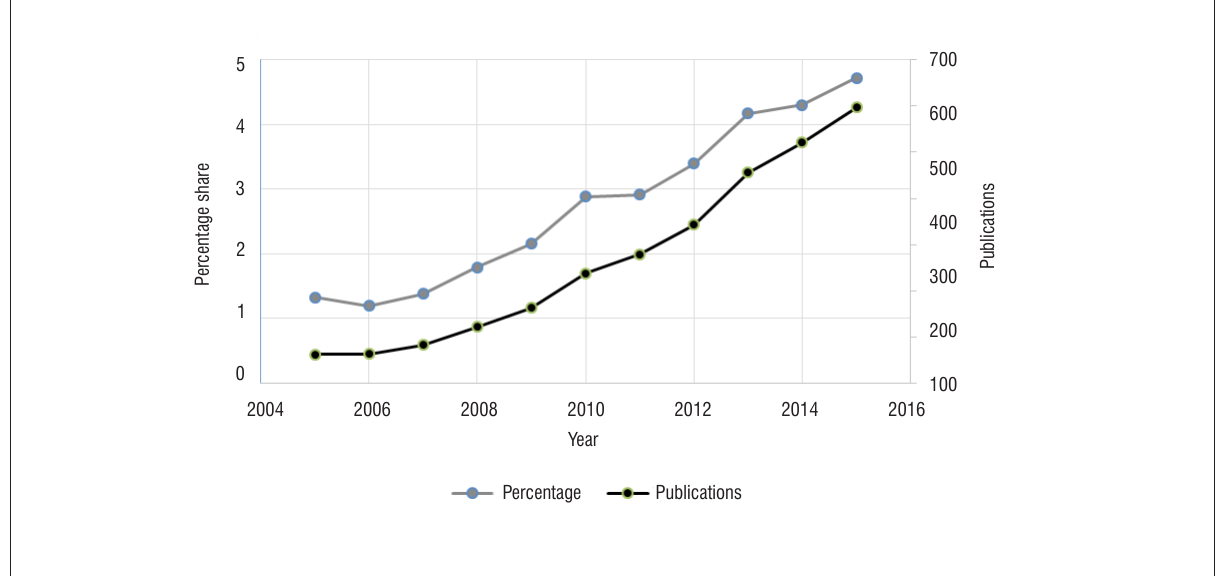
Figure 1: The publication trend as well as percentage of nanotechnology articles relative to the total number of articles in South Africa from 2005 to